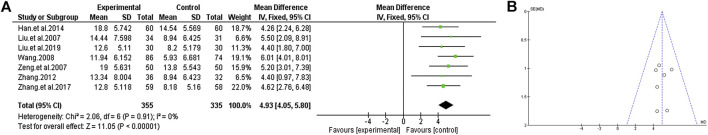
The negative score of TCM auxiliary antipsychotics vs. antipsychotics therapy alone. (A) Forest plot. (B) Funnel plot.